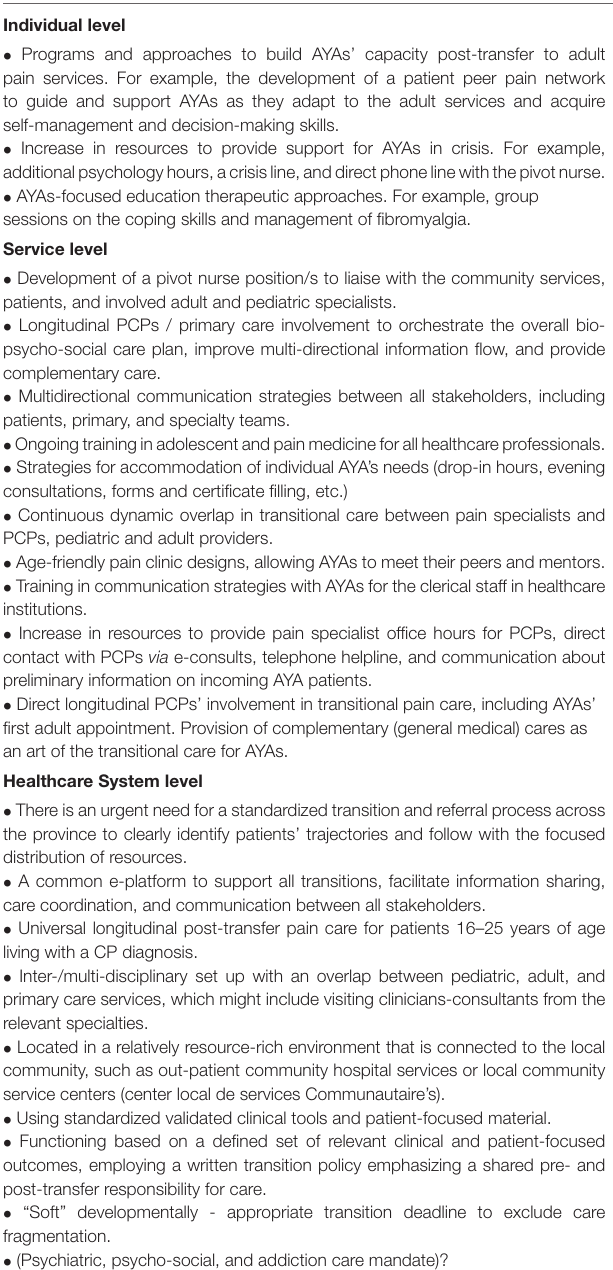
TABLE 2 | TRAST transitional pain care model would involve all three